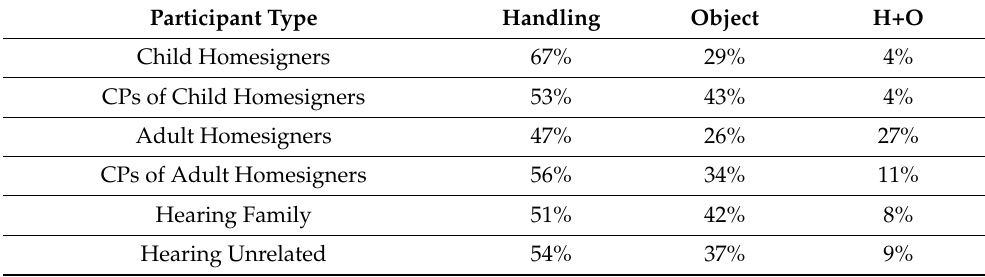
Table 4. Mean iconic handshape preferences of child/adolescent and adult homesigners, communi- cation partners (CPs) and hearing non-signers (related and unrelated). H+O stands for combined Handling+Object handshape. See Appendix A for individual and group preferences. Participant Type Handling Object H+O Child